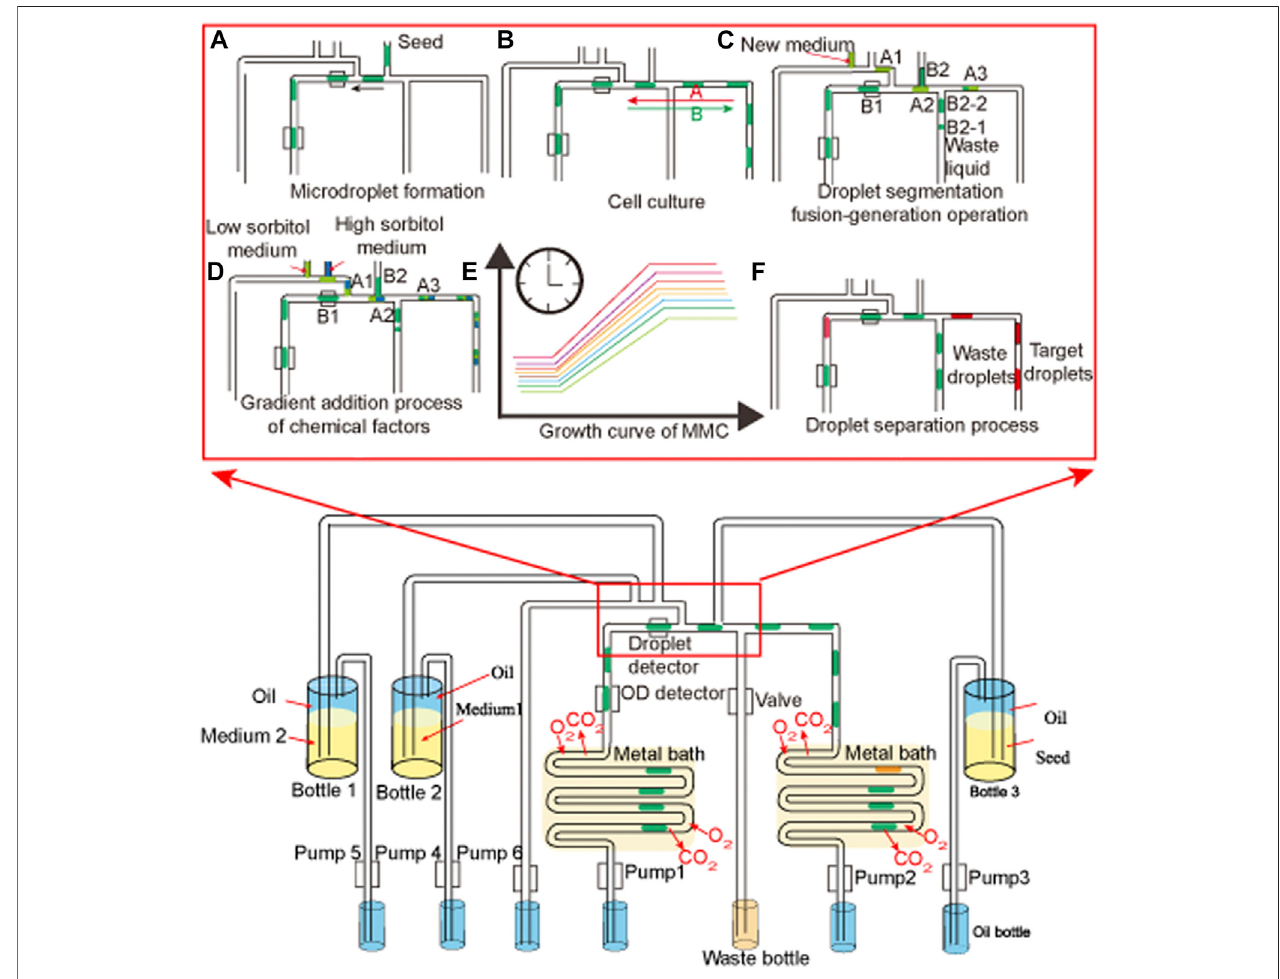
FIGURE 1 | Diagram of the operation of the microdroplet culture system. (A) Microdroplet formation, (B) cell culture, (C) droplet segmentation fusion-generation operation, (D) gradient addition process of chemical factors, (E) growth curve of MMC, and (F) droplet separation process.